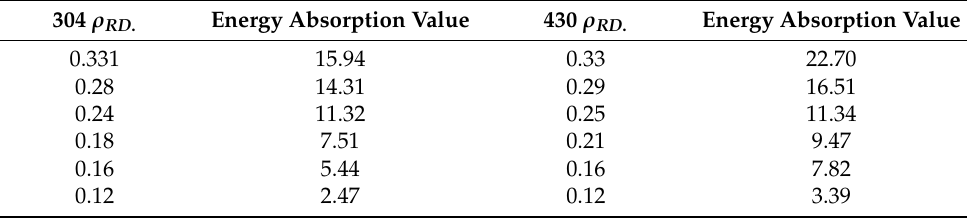
Figure 9. The relation of energy absorption value and strain at different relative densities: ( a ) 304; ( b ) 430. Table 3. The energy absorption value of the 304 and 430 SSFs (MJ/m 3 ).